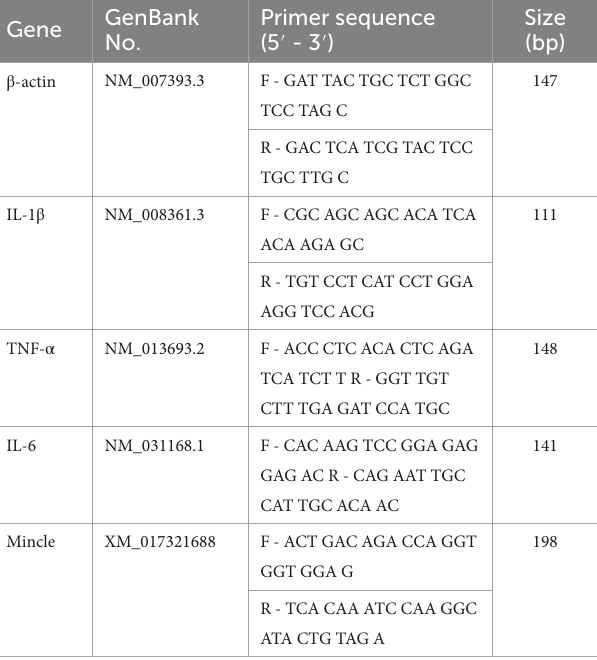
TABLE 1 Nucleotide sequences of mouse primers for RT-PCR.